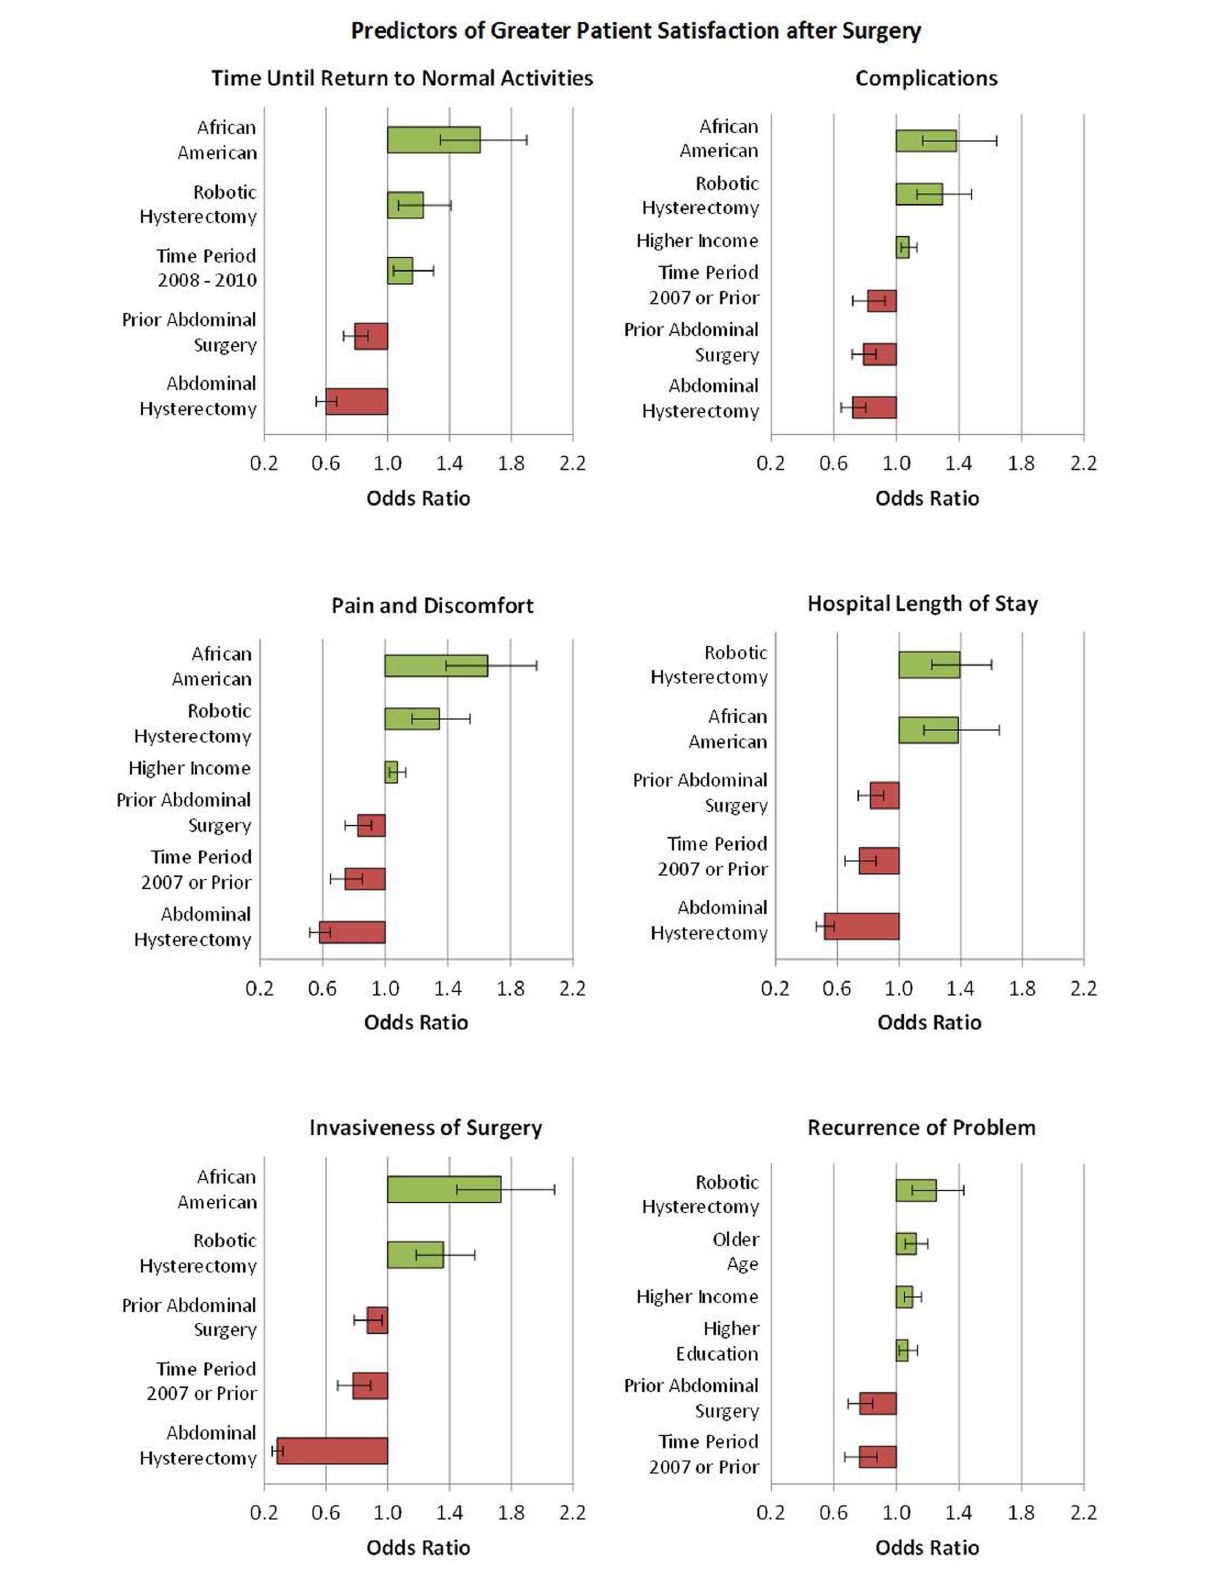
Figure 3. Independent predictors of greater patient satisfaction after